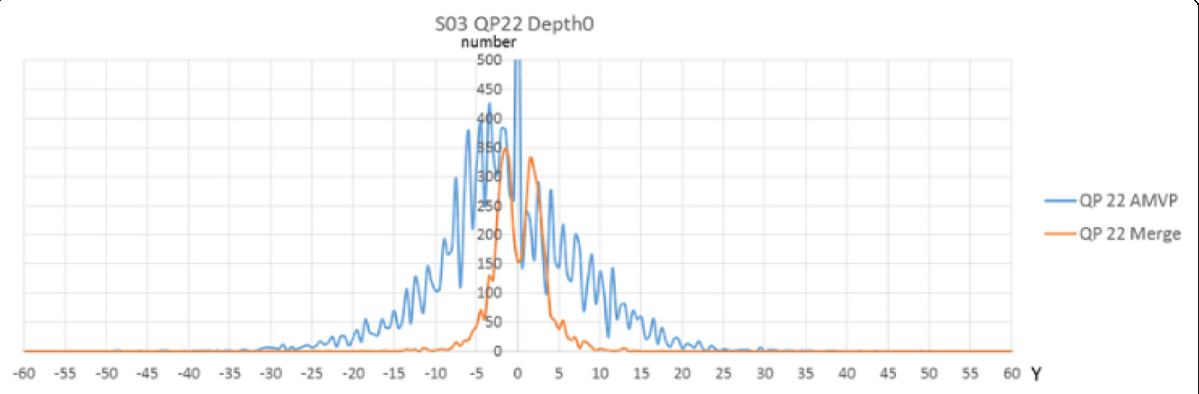
Fig. 7 The distribution of vertical component for the S03